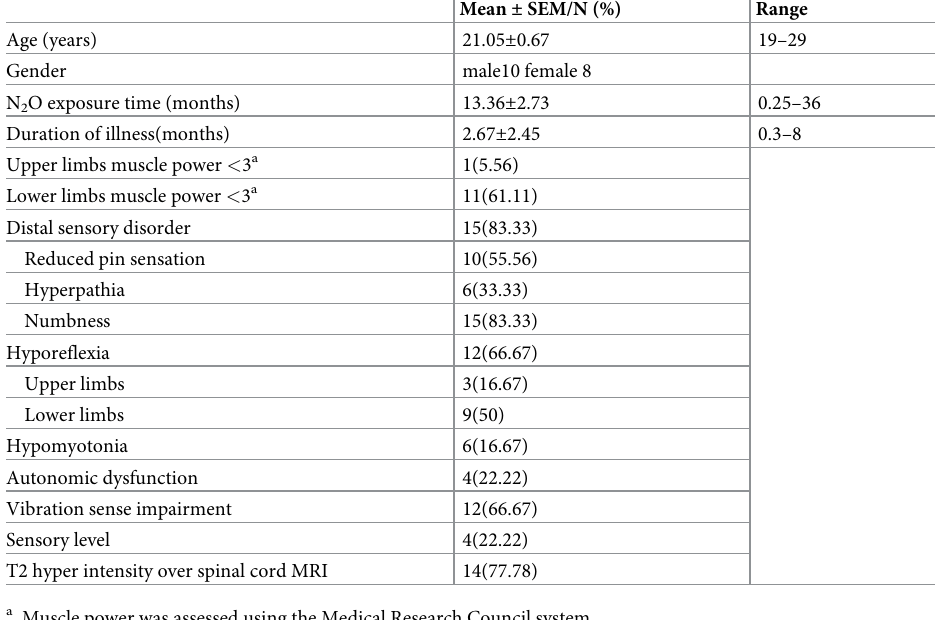
Table 1. Demographics and clinical data of the 18 patients.